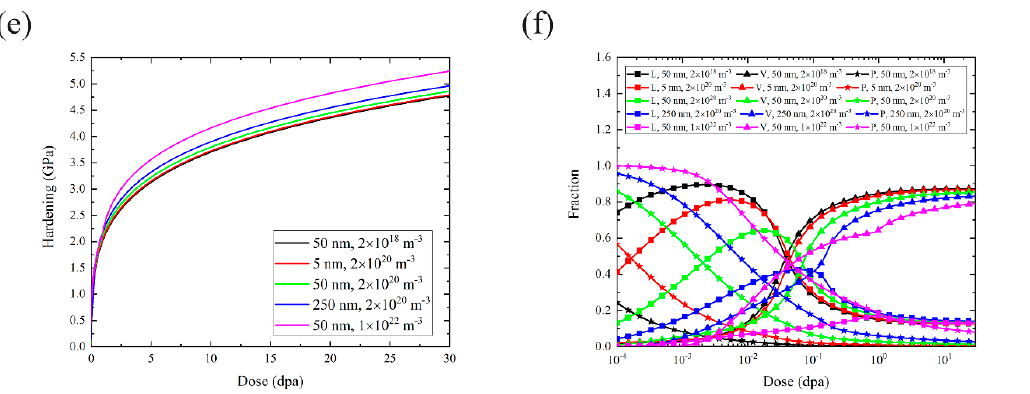
Figure 4. Rate theory calculations with various sizes and densities of precipitates. ( a ) Number density and diameter of loops. ( b ) Number density and diameter of voids. ( c ) Distribution of loops at 0.2 dpa, 5 dpa and 30 dpa. ( d ) Dislocation density. ( e ) Hardening. ( f ) Contribution of loops (L), voids (V) and precipitates (P) to hardening.